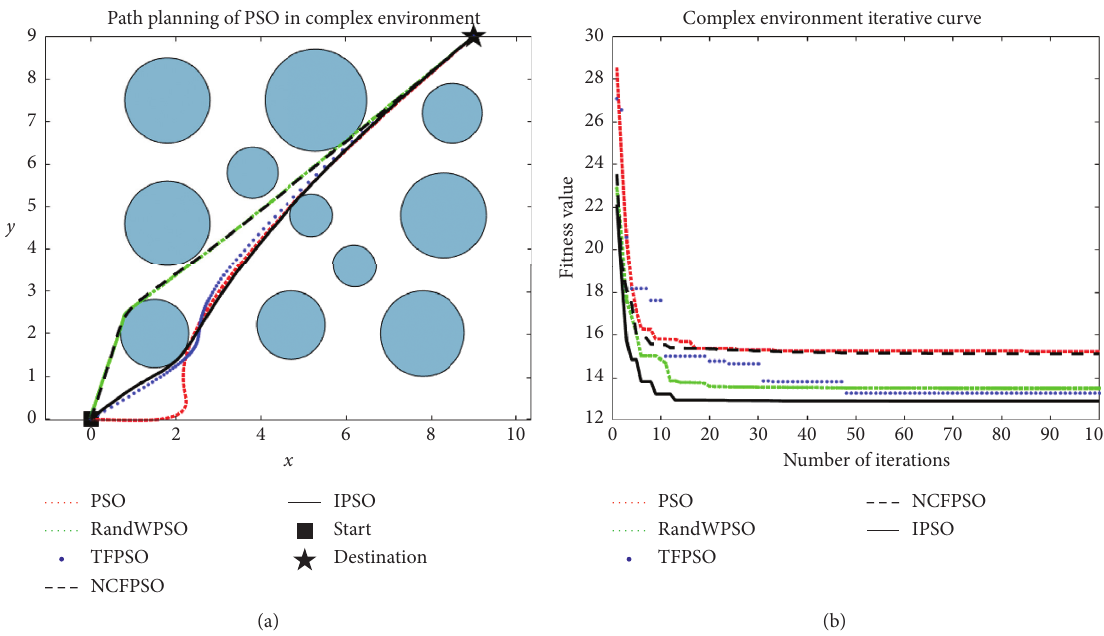
Figure 4: The first experimental comparison of five algorithms in the complex environment. (a) The first type of complex environment path planning diagram. (b) The first type of complex environment iteration